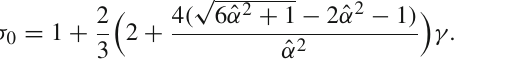
optical conductivity fitted with the standard Drude formula. (For inter- pretation of the references to color in this figure, the reader is referred to the web version of this paper)